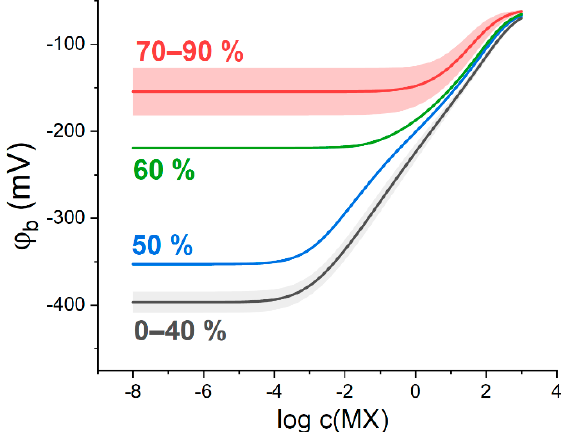
Figure 5. The simulated response curves for the membranes containing both IR and Q + B − in molar ratios from 0 to 40% (black curve), 50% (blue curve), 60% (green curve) and from 70 to 90% (red curve). When possible, for better clarity, the values of E for the membranes with different IR content were averaged and the resulting dispersion of the potential difference is represented as shaded areas (see Figure S3 for all the individual curves). k M = 10 − 6 , k X = 10 − 4 ; k Q = 10 9 , k B = 10 5 ; k I = 10 − 5 ; k R = 10 9 ; c ( QB + IR ) = 10 − 2 M.